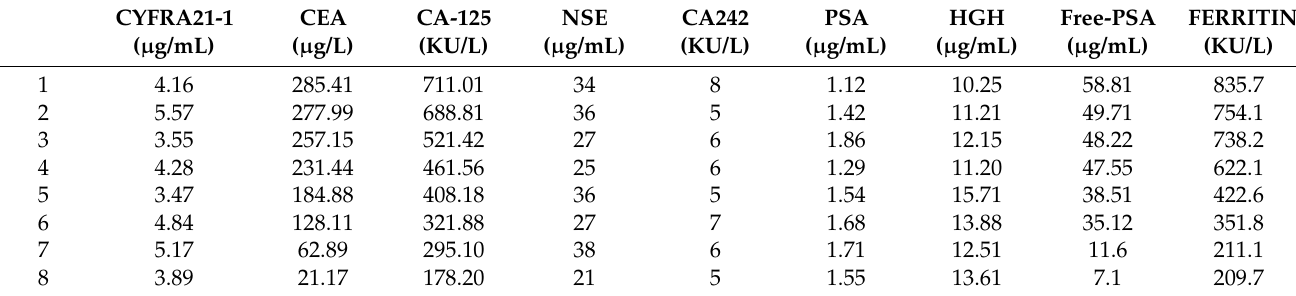
Table 6. The data of various diagnostic and decision parameters during the treatment of a typical NSCLC patient. CYFRA21-1